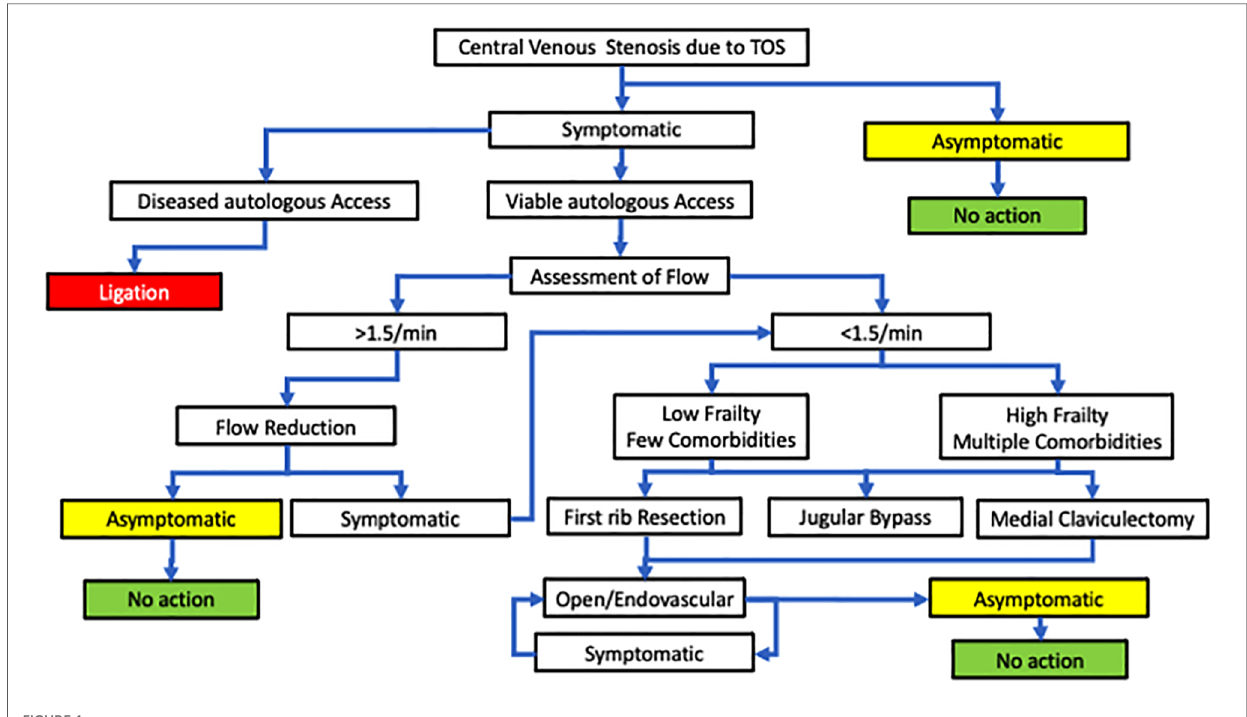
FIGURE 1 An algorithm to treat central venous stenosis due to thoracic outlet